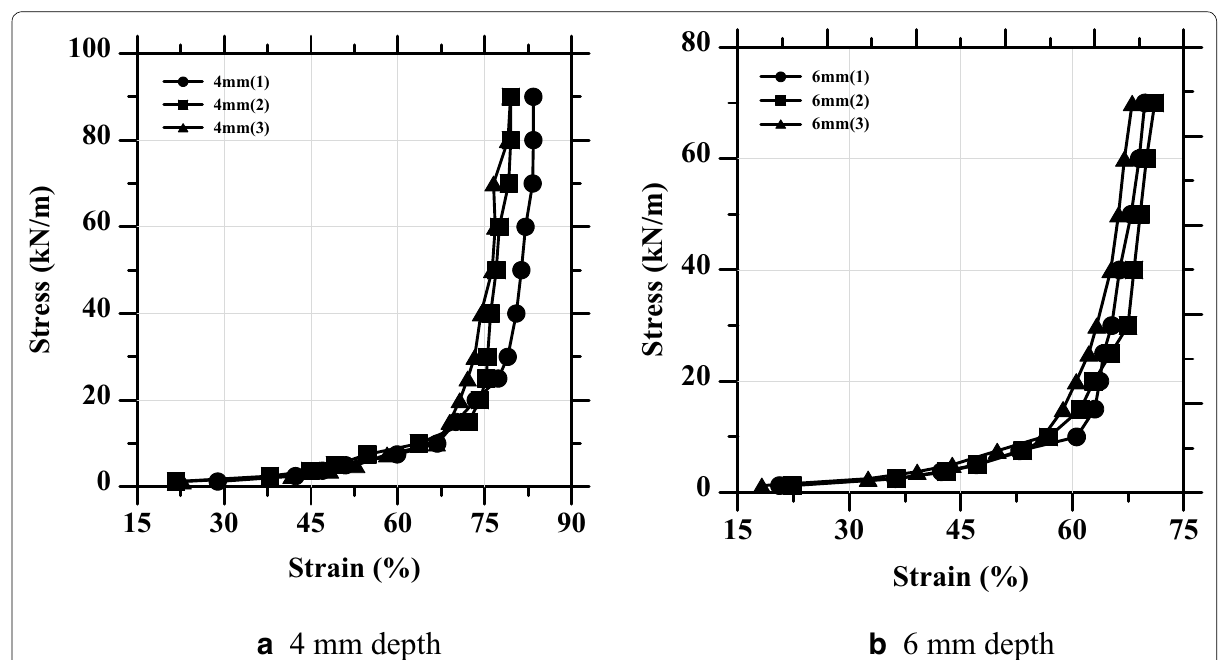
Fig. 9 Test results of the compression test for the putty‑based composite rubber strip: a 4 mm depth; and b 6 mm depth.